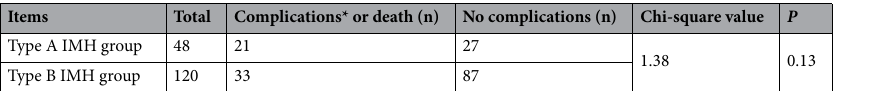
Table 14. Comparative analysis of the efficacy of different types of IMH patients. *Progression of aortic dissection, pseudoaneurysm, rupture, visceral arterial perfusion, lower limb ischemia.